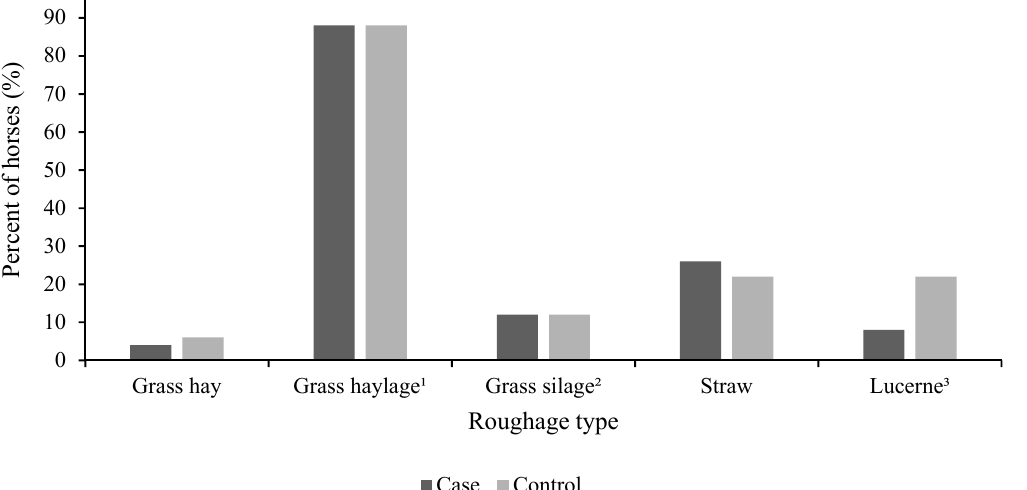
Figure 1. Proportions of horses with (case, n = 50) and without (control, n = 50) free faecal liquid fed various roughage types. The same horse may have been fed multiple roughages, resulting in a sum exceeding 100%. 1 Wrapped forage with ≥ 50% dry matter. 2 Wrapped forage with ≤ 50% dry matter. 3 Includes both pellets and chaff. p > 0.05 for all feed types. Table 2. Minimum, median, maximum, mean and standard deviation (SD) values for the amounts of specific types of feeds (kg DM per 100 kg body weight and day), total daily feed intake and total intake of feed components (grams per 100 kg of body weight per day unless otherwise stated in the table) for farm-matched pairs of horses with (case, n = 50) and without (control, n = 50) free faecal liquid. Not all horses were fed all listed feed types.